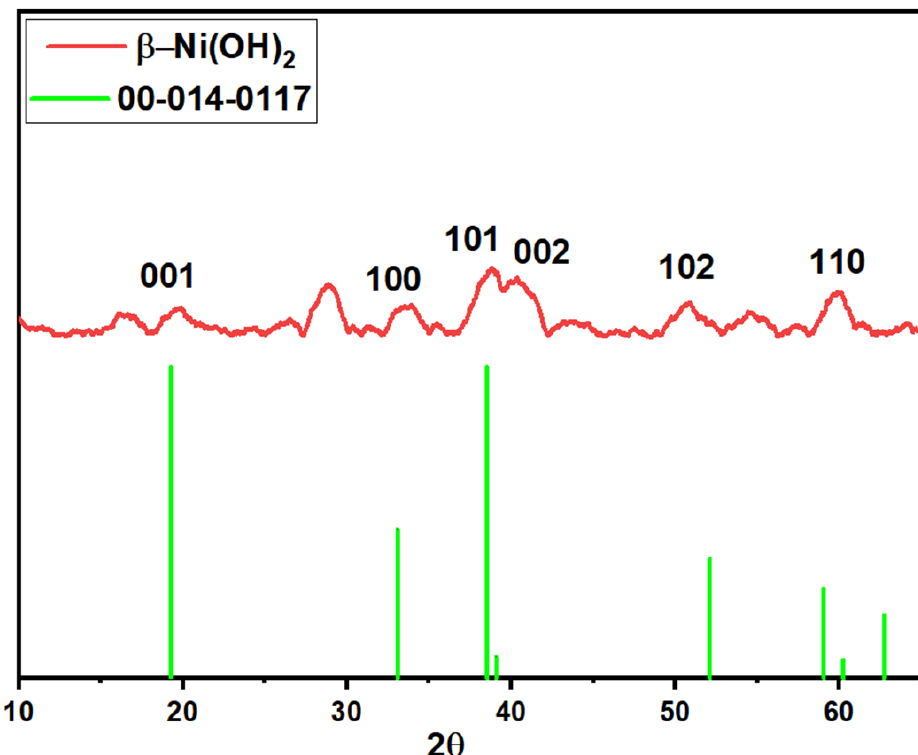
Figure 4. X-Ray Diffraction of Synthesized β -Ni(OH) 2 nanocluster.